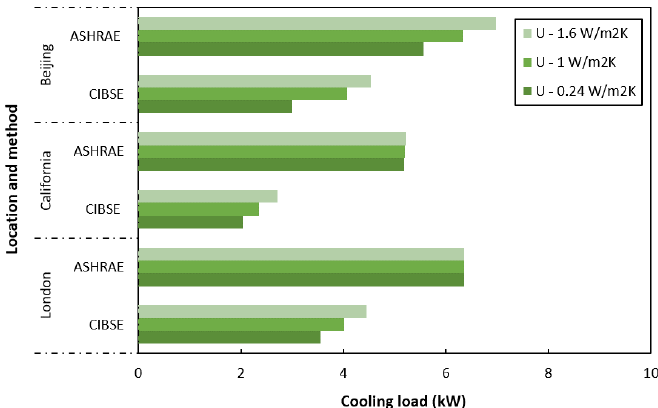
Figure 6. Building fabric U-value impacts on peak heat gains.